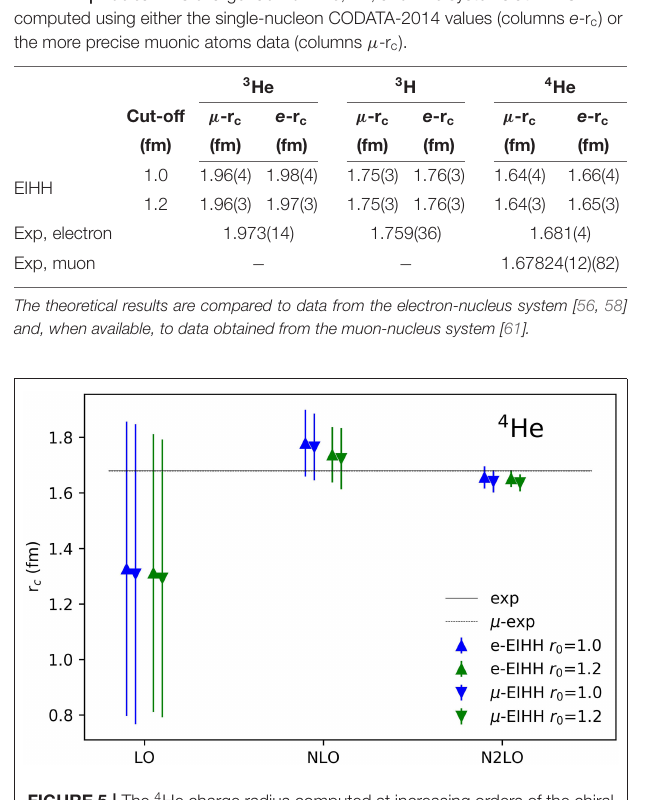
FIGURE 5 | The 4 He charge radius computed at increasing orders of the chiral expansion. The uncertainty bars include the numerical uncertainty of the EIHH method as well as the uncertainties coming from the truncation of the chiral expansion. The horizontal lines are the experimental values from electron scattering (solid line) [ 56] and from muonic atoms (dashed line)